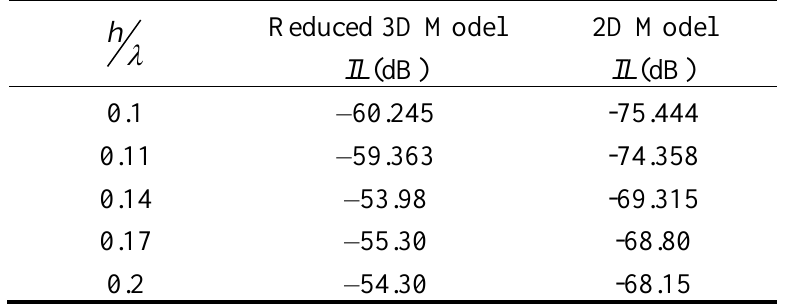
Table 5. Insertion loss values for the R3D model and the 2D